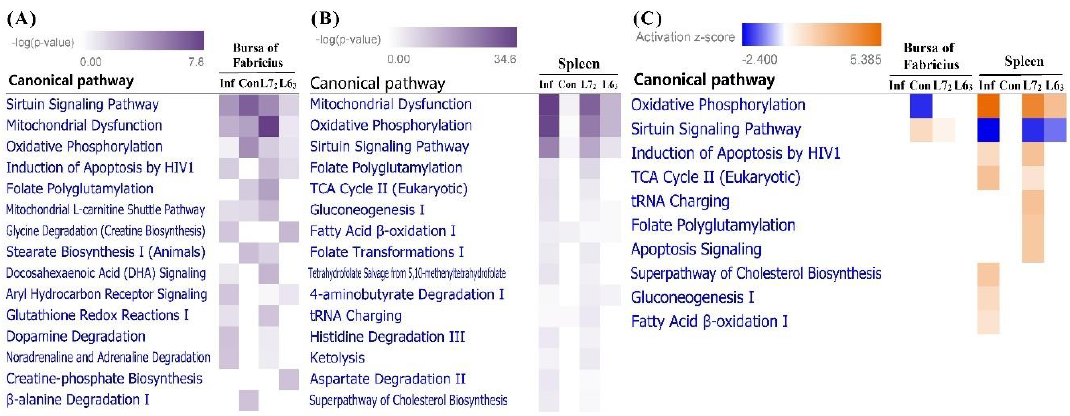
Figure 5. Ingenuity Pathway Analysis (IPA). ( A ) Top 15 canonical pathways based on the DEGs in bursa of Fabricius. ( B ) Top 15 canonical pathways based on the DEGs in spleen. ( C ) The canonical pathways with absolute z-score ≥ 1 in bursa and spleen. Pathways are sorted by p -value or absolute z-score, and the intensity of colors indicates the higher or lower value.